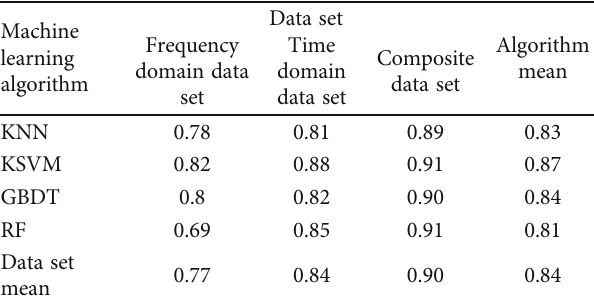
Algorithm meanFrequency